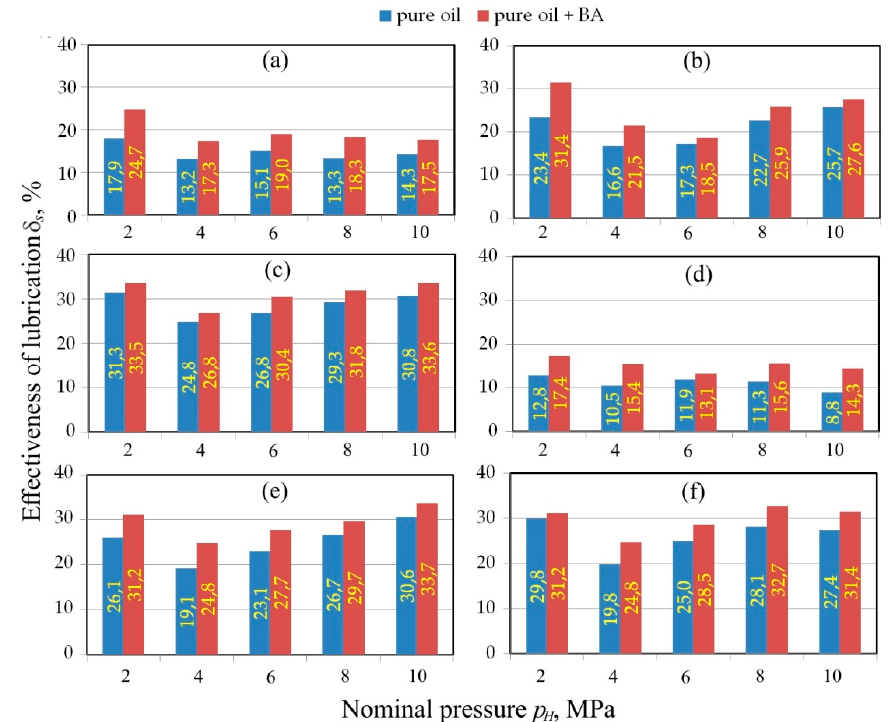
Figure 10. Comparison of the effectiveness of lubrication for tests carried out under the range of nominal pressure between 2 and 10 MPa for different oils: ( a ) linseed, ( b ) olive, ( c ) palm, ( d ) rapeseed, ( e ) soybean, ( f ) sunflower.